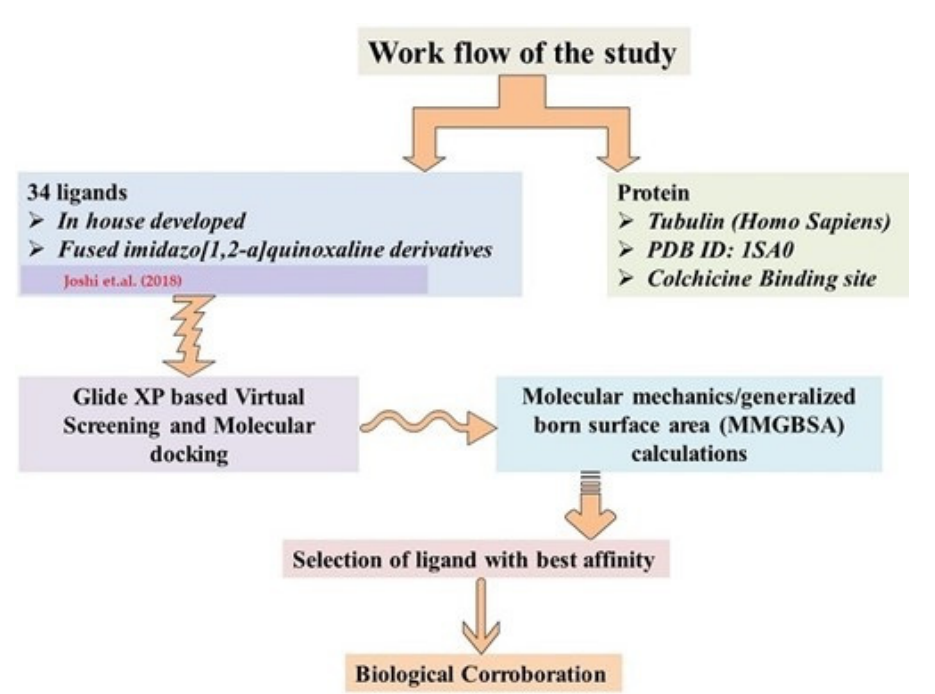
Figure 7. The flowchart illustration portrays the brief methodology of the proposed work [12].